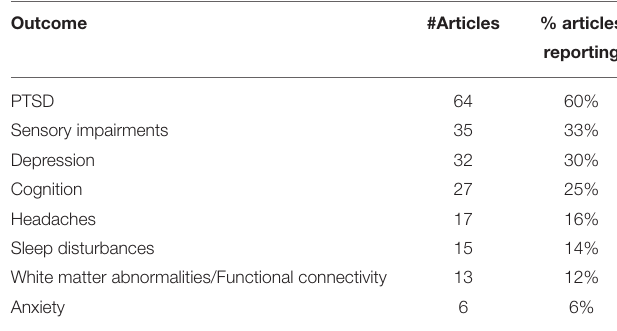
TABLE 8 | The number of and percentage of major outcomes